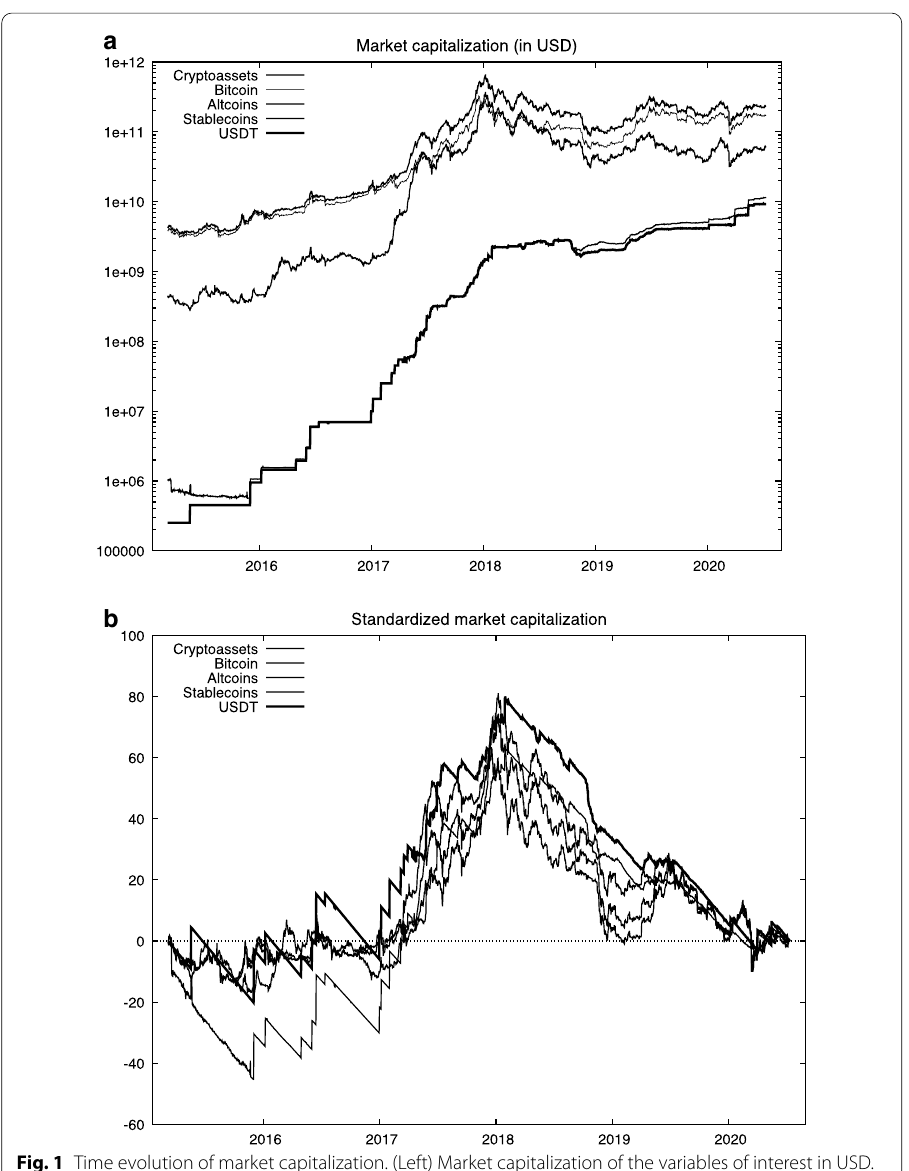
Fig. 1 Time evolution of market capitalization. (Left) Market capitalization of the variables of interest in USD. (Right) Integrated demeaned and standardized logarithmic first differences of the variables of interest. All series are shown between 6 March 2015 and 11 July 2020, giving 1955